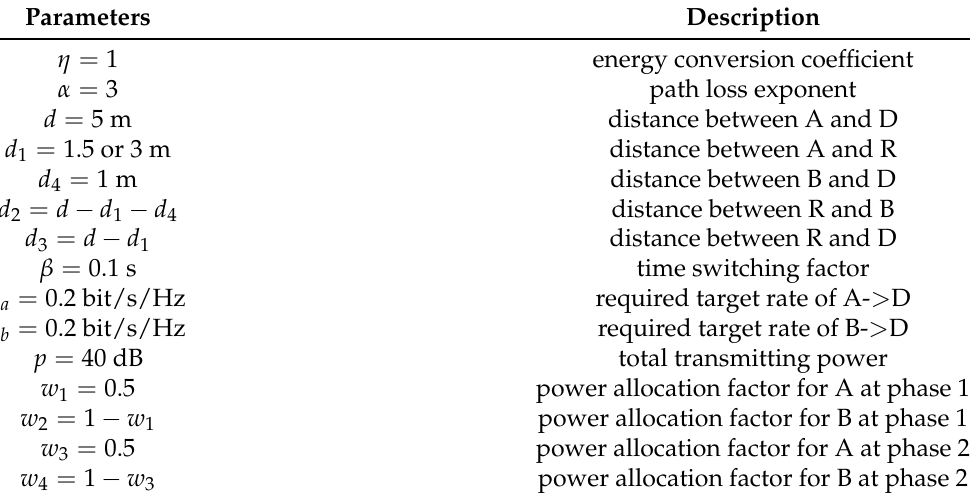
Table 2. Simulation Parameters by Default.